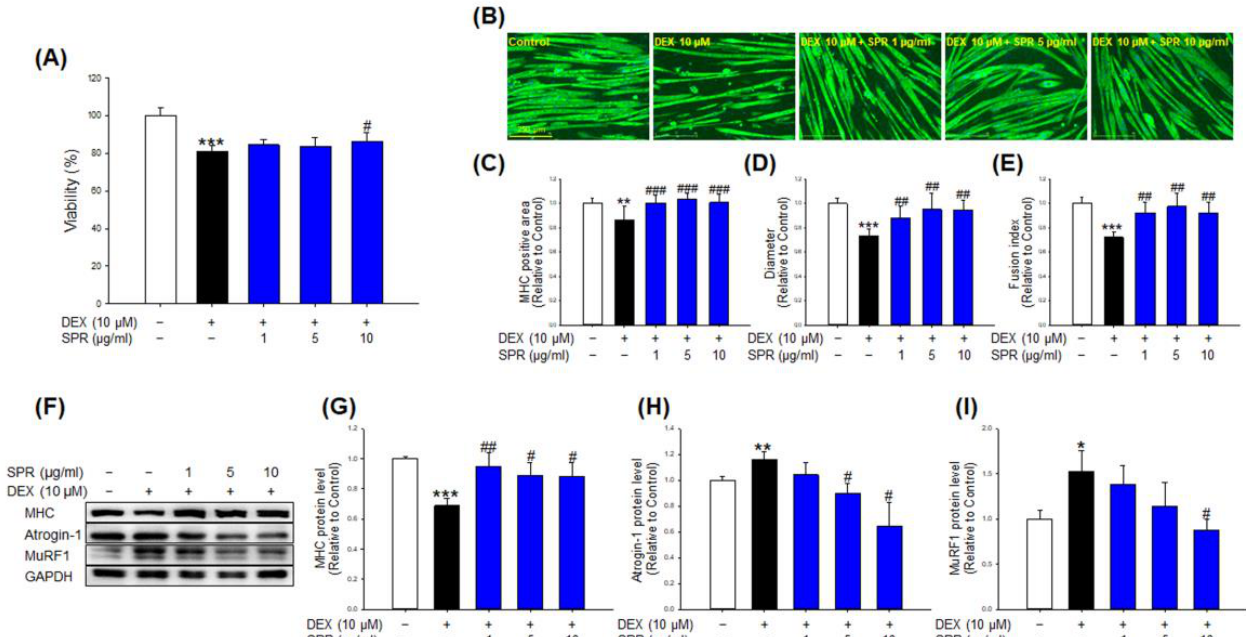
Figure 1. Effects of SPR on viability, morphology, and expression of muscle atrophy-related proteins in the DEX-induced C2C12 myotubes. ( A ) C2C12 myotubes were treated with DEX (10 µ M) in the presence or absence of SPR (1, 5, and 10 µ g/mL) for 24 h. ( B ) C2C12 myotubes were stained with MHC (green) and DAPI (blue), and representative photographs were observed under a fluorescent microscope (scale bar = 250 µ m). ( C ) Relative change in MHC-stained area in myotubes, ( D ) diameters, and ( E ) fusion index were measured from randomly selected fields and were quantified using the Image J program. ( F ) Expressions of MHC, Atrogin-1, MuRF1, and GPADH were analyzed in C2C12 myotubes by western blotting. GAPDH was used as the loading control. ( G ) Quantitative analysis of MHC, ( H ) Atrogin-1, and ( I ) MuRF1. These results are presented as the means ± SD of three independent experiments: * p < 0.05, ** p < 0.01, *** p < 0.001 vs. control; # p < 0.05, ## p < 0.01, ### p < 0.001 vs. DEX.